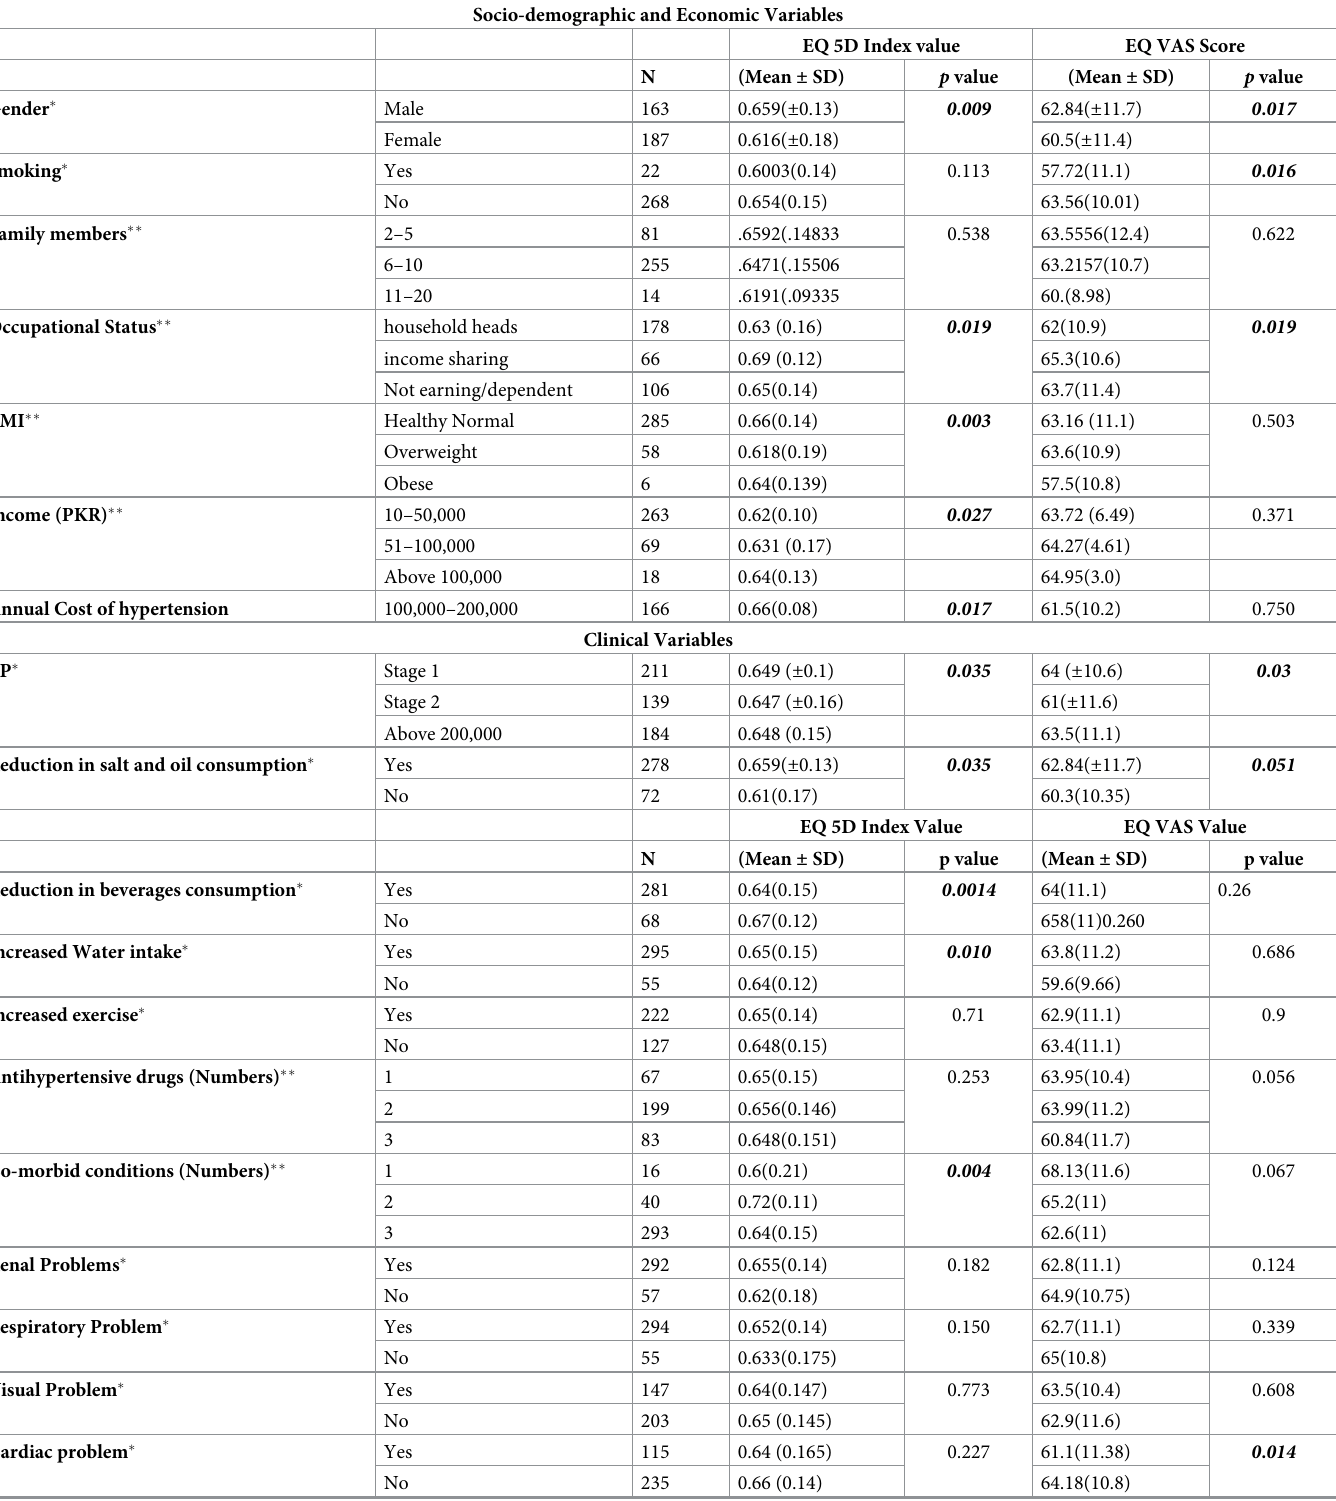
Table 4. Effect of socio-demographic, economic and clinical variables on health related quality of life. Socio-demographic and Economic